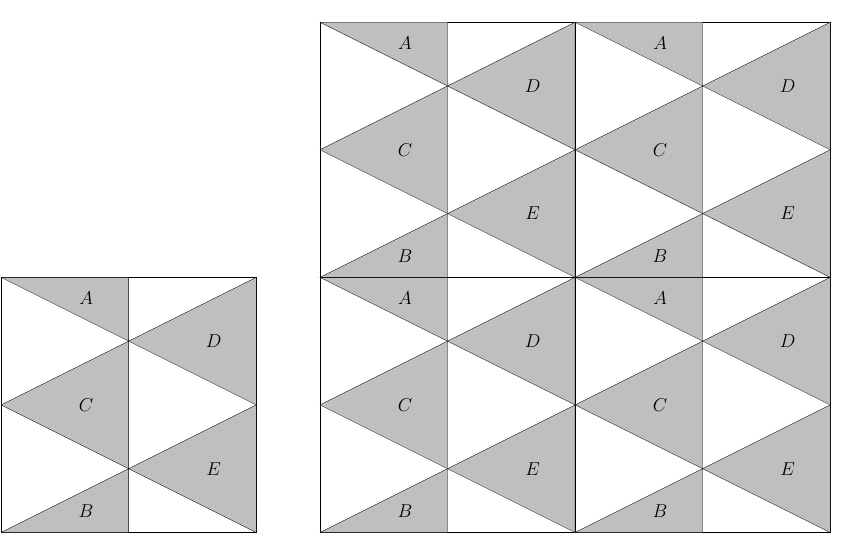
is similar to the one on the left, then Figure 17: If we assume that the pattern of D η n − 1 from Lemma 4 we can deduce that the maximum pattern of D η is the one on the right. n mess with the pattern, and the obtained ddt does not look like a refined version of the smaller instance. Hopefully, as seen in Lemma 4, some parts are erased (namely a part of C in the left half, A and C in the right half), and thanks to that we obtain something that meets our expectations (see Figure 18).